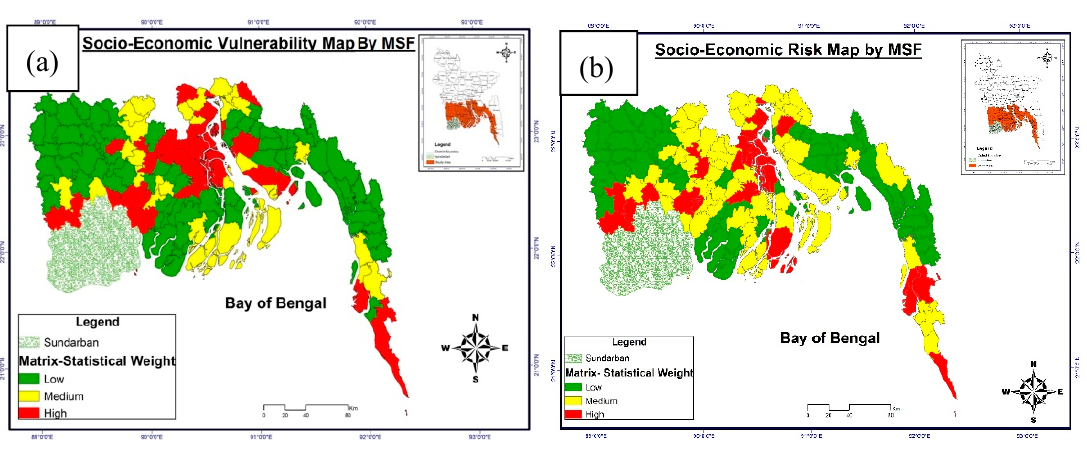
Table 3. Weights of various socio ‐ economic indicators computed by MSF and other weight methods.